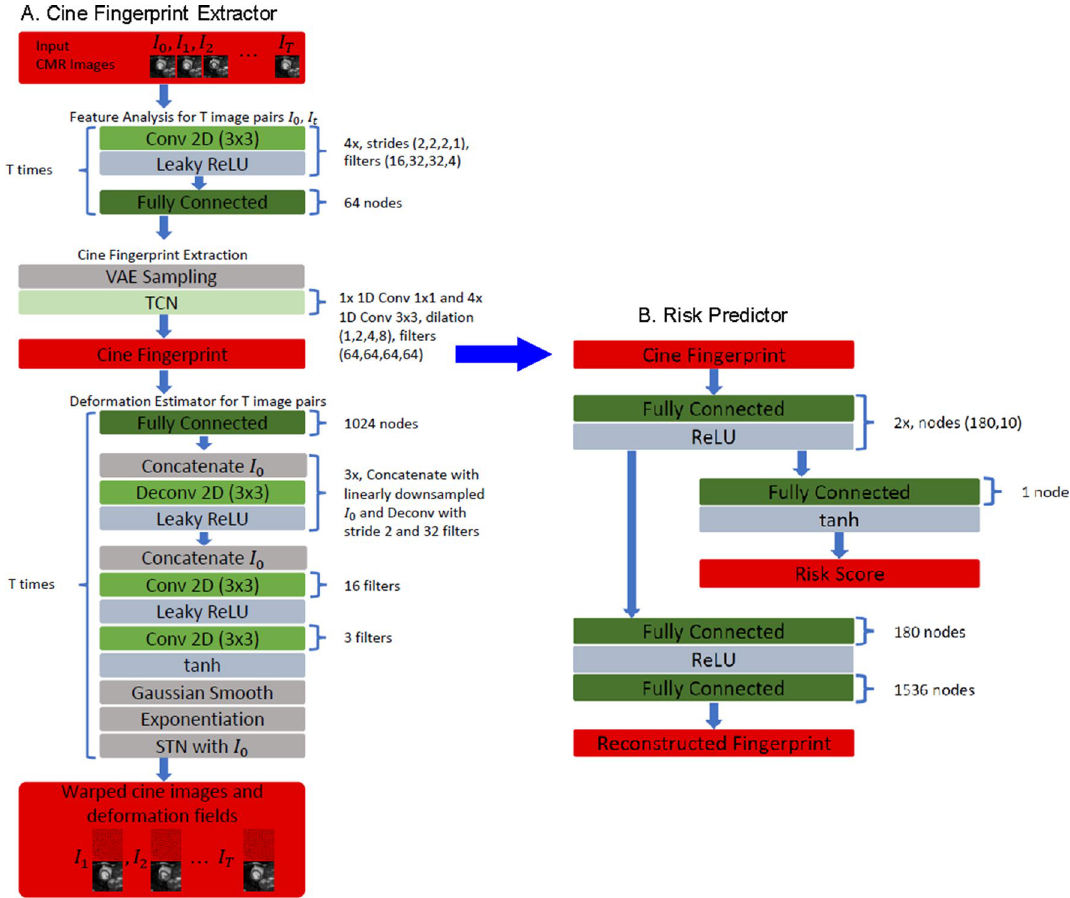
Figure 1. Algorithm overview. ( A ) Cine fingerprint extractor. ( B ) Risk predictor. See text for details.